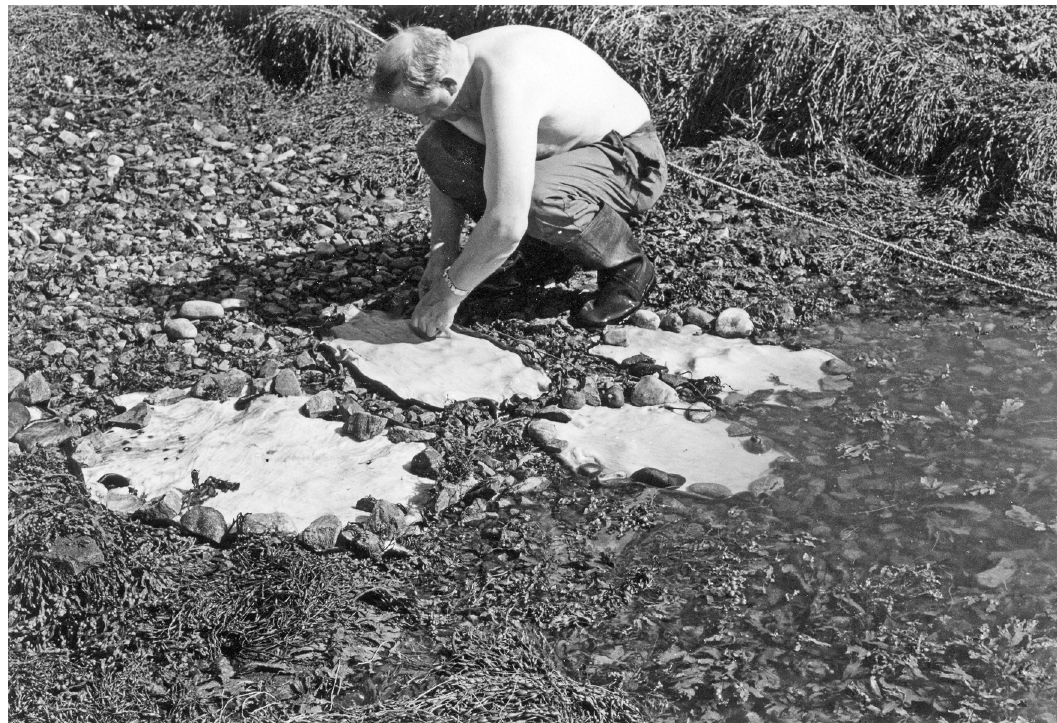
Figure 1: Habour seal ( Phoca vitulina ) hides stretched out and soaked in the tidal water zone, Måsvær, North Norway, in 1972. Harbour seal hides vary considerably in colour and pattern. Traditional hide processing documented by H. D. Bratrein, UiT – The Arctic University of